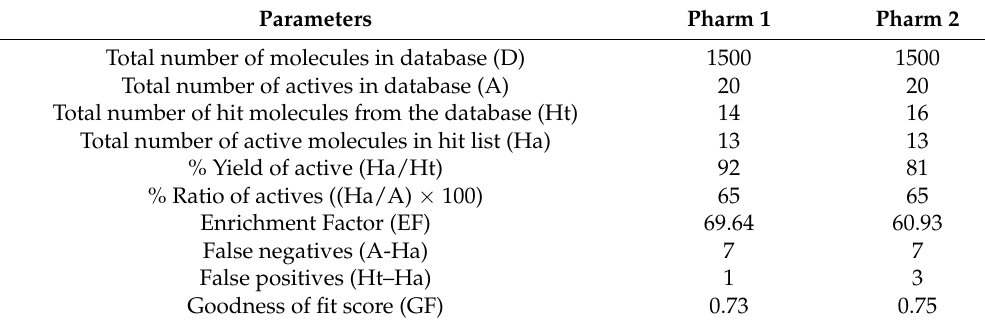
Figure 1. Pharmacophore generation. ( A ) pharm 1 with key residues complementary to the target 3EQM, ( B ) pharm 1 with interfeature distance, ( C ) pharm 2 with key residues complementary to the target 3S7S, and ( D ) pharm 2 with interfeature distance. Table 1. Decoy set values computed for pharm 1 and pharm